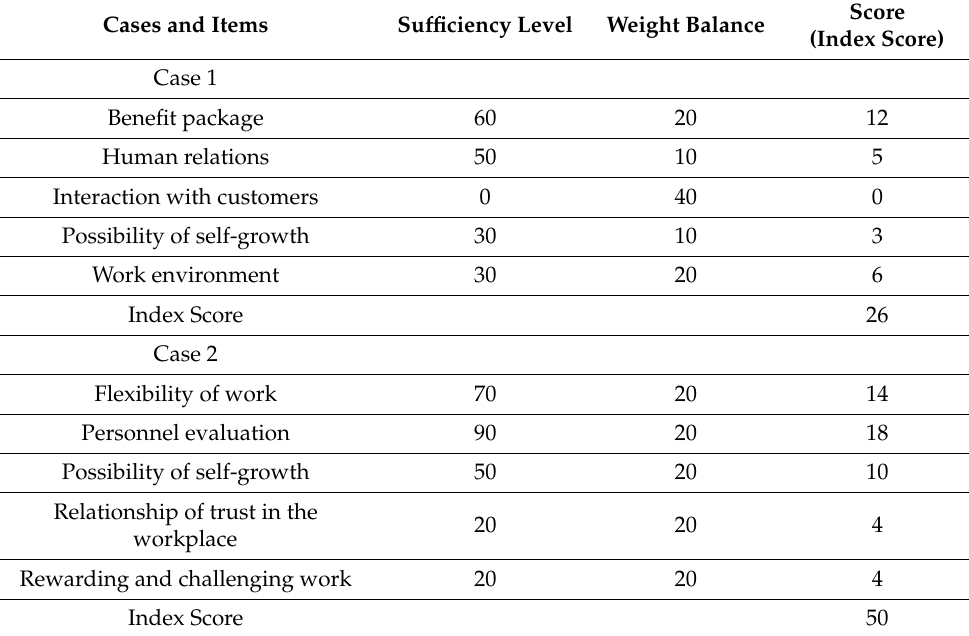
Table 6. Examples of results in SWING for individual